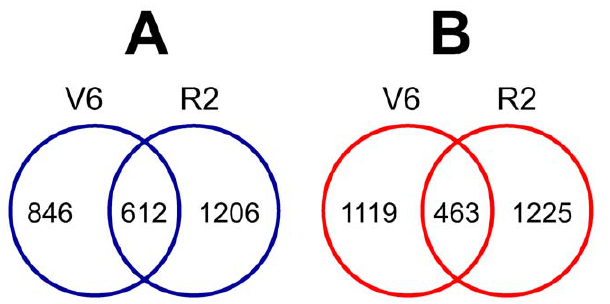
Figure 1. Venn diagram analysis of differentially expressed gene sets of comparision V6-D/V6-C and R2-D/R2-C. (A) Numbers of the overlapping and non-overlapping upregulated genes. (B) Number of the overlapping and non-overlapping downregulated genes.